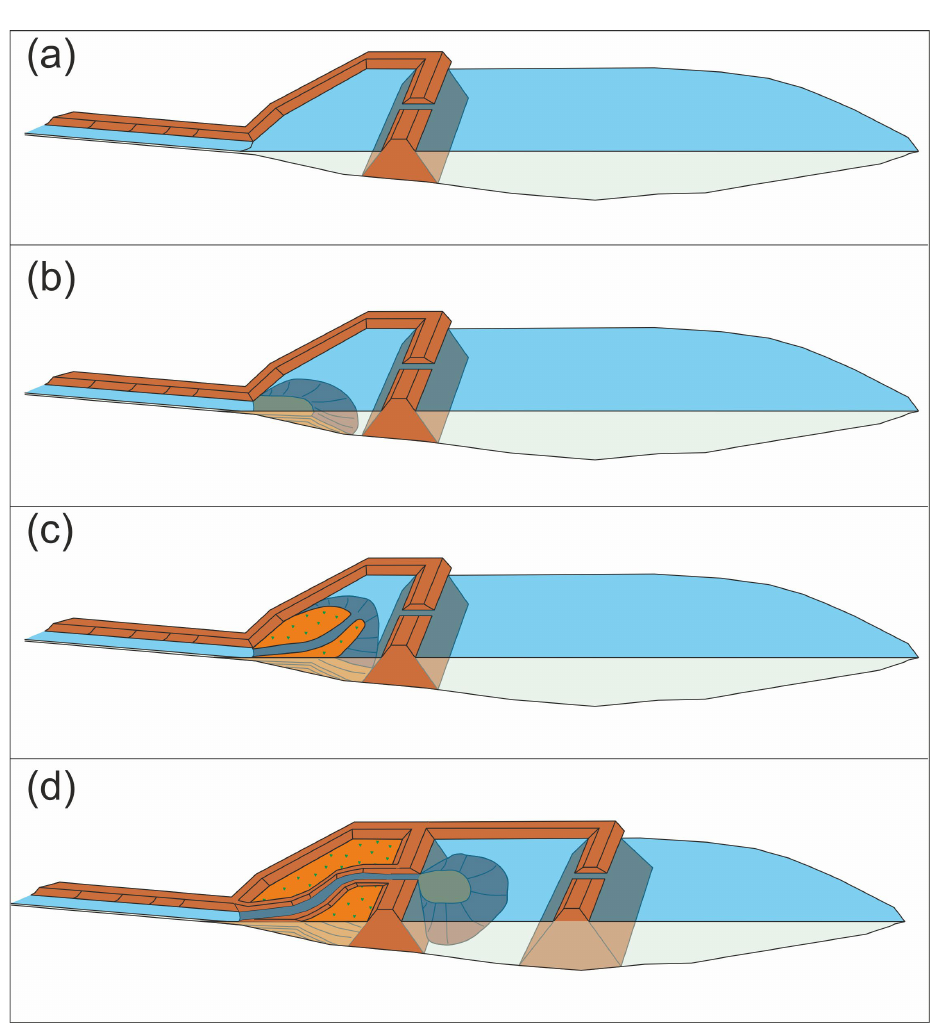
Figure 9. Schematic diagram of the process of the functioning of a filled polder: ( a ) delimitation with an embankment of a part of the area to be reclaimed (creation of a backfill basin), into which a natural stream or an artificial canal flows; ( b , c ) filling phase of the polder: the sediment transported by the stream or canal is deposited in the basin, and the water escapes from the basin through an ‘overflow’ type opening; ( d ) once the basin is filled, a new stretch of the canal is created within it and the filling of the next polder, built in the meantime, starts.